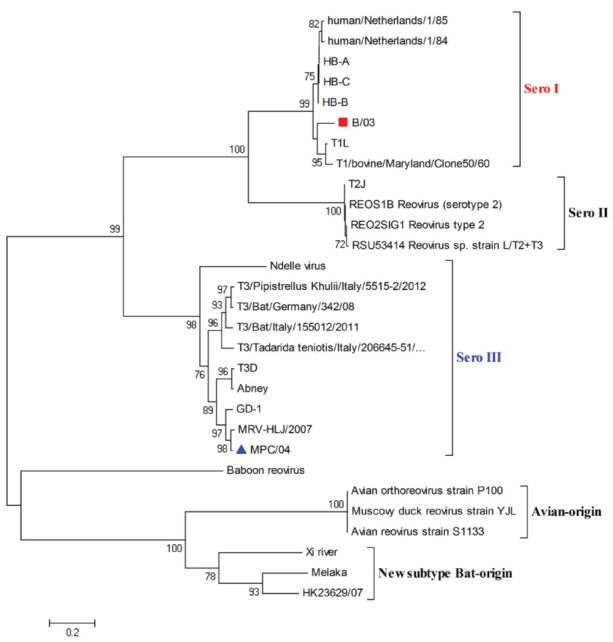
Phylogenetic analysis of reovirus S1 gene sequences. The scale bar represents the nucleotide substitutions per site. The numbers above and below the branches indicate bootstrap values. Bootstrap support values > 70 are shown (1000 replicates). ■ (B/03) and ▲ (MPC/04) indicate the two viruses characterized in this study.